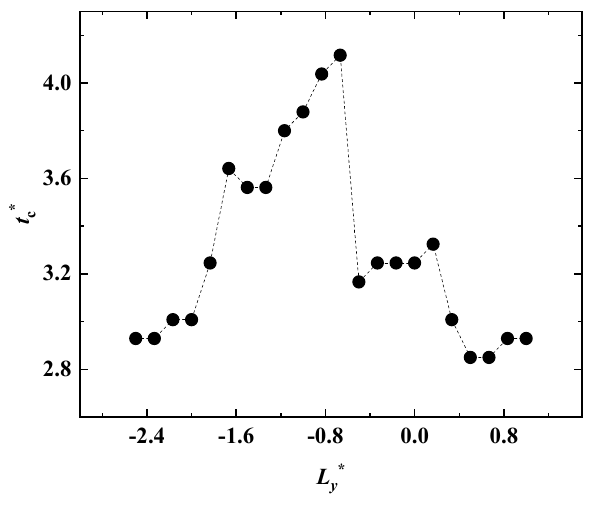
Figure 12. The contact time versus L y * .